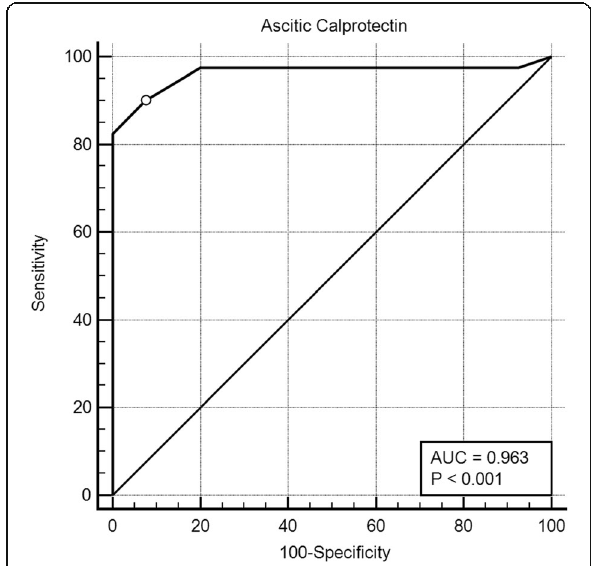
Fig. 1 The receiver operating characteristic (ROC) curve analysis of ascitic calprotectin